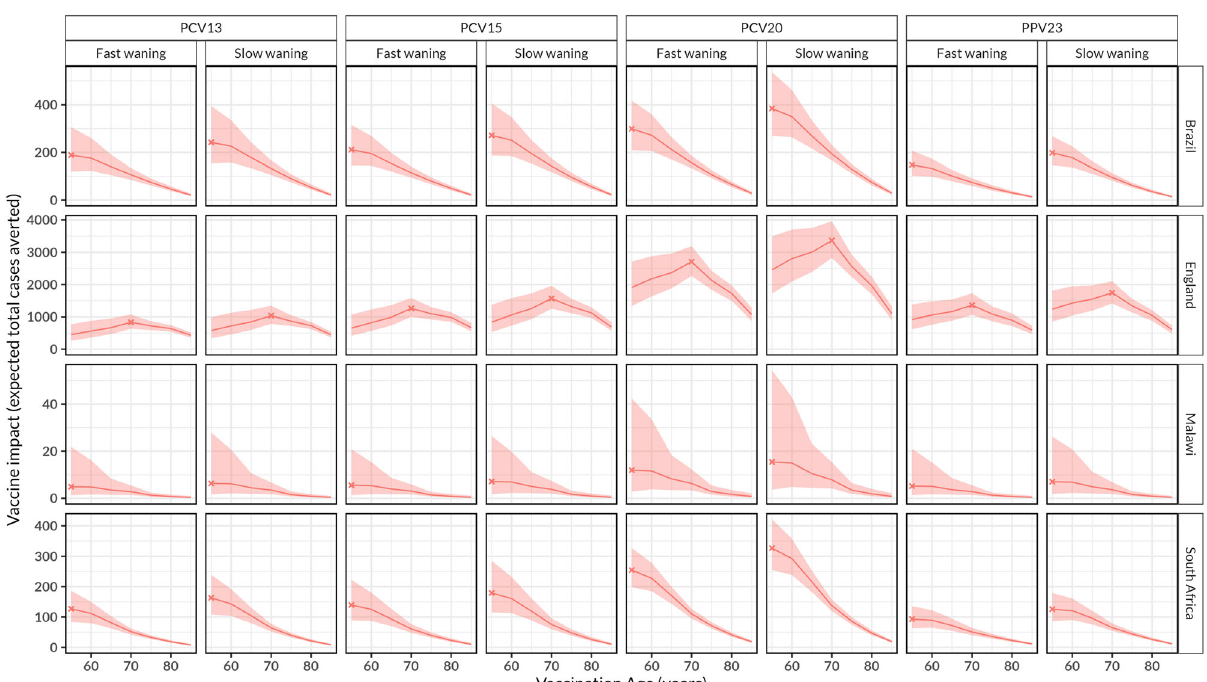
Fig. 2 | The impact of routine pneumococcal vaccination in older adults aged ≥ 55yearsold(y). TheexpectedabsolutenumberoftotalIPDcasesavertedforthe rest of age cohort lifetime by vaccinating every older adult in the age cohort strati fi ed by country and vaccine product, under the scenario of age-independent initial vaccine ef fi cacy/effectiveness (VE) and waning VE in Brazil, England, Malawi